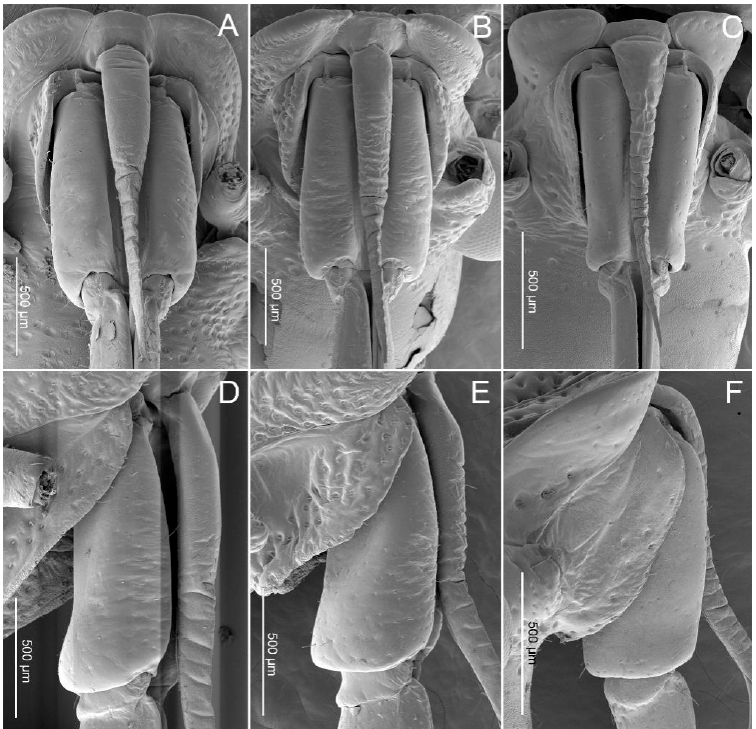
Figure 3. SEM images of the labrum and first labial segment. ( A ) Ventral view of Picromerus bidens ; ( B ) Ventral view of Picromerus lewisi ; ( C ) Ventral view of Cazira bhoutanica ; ( D ) Lateral view